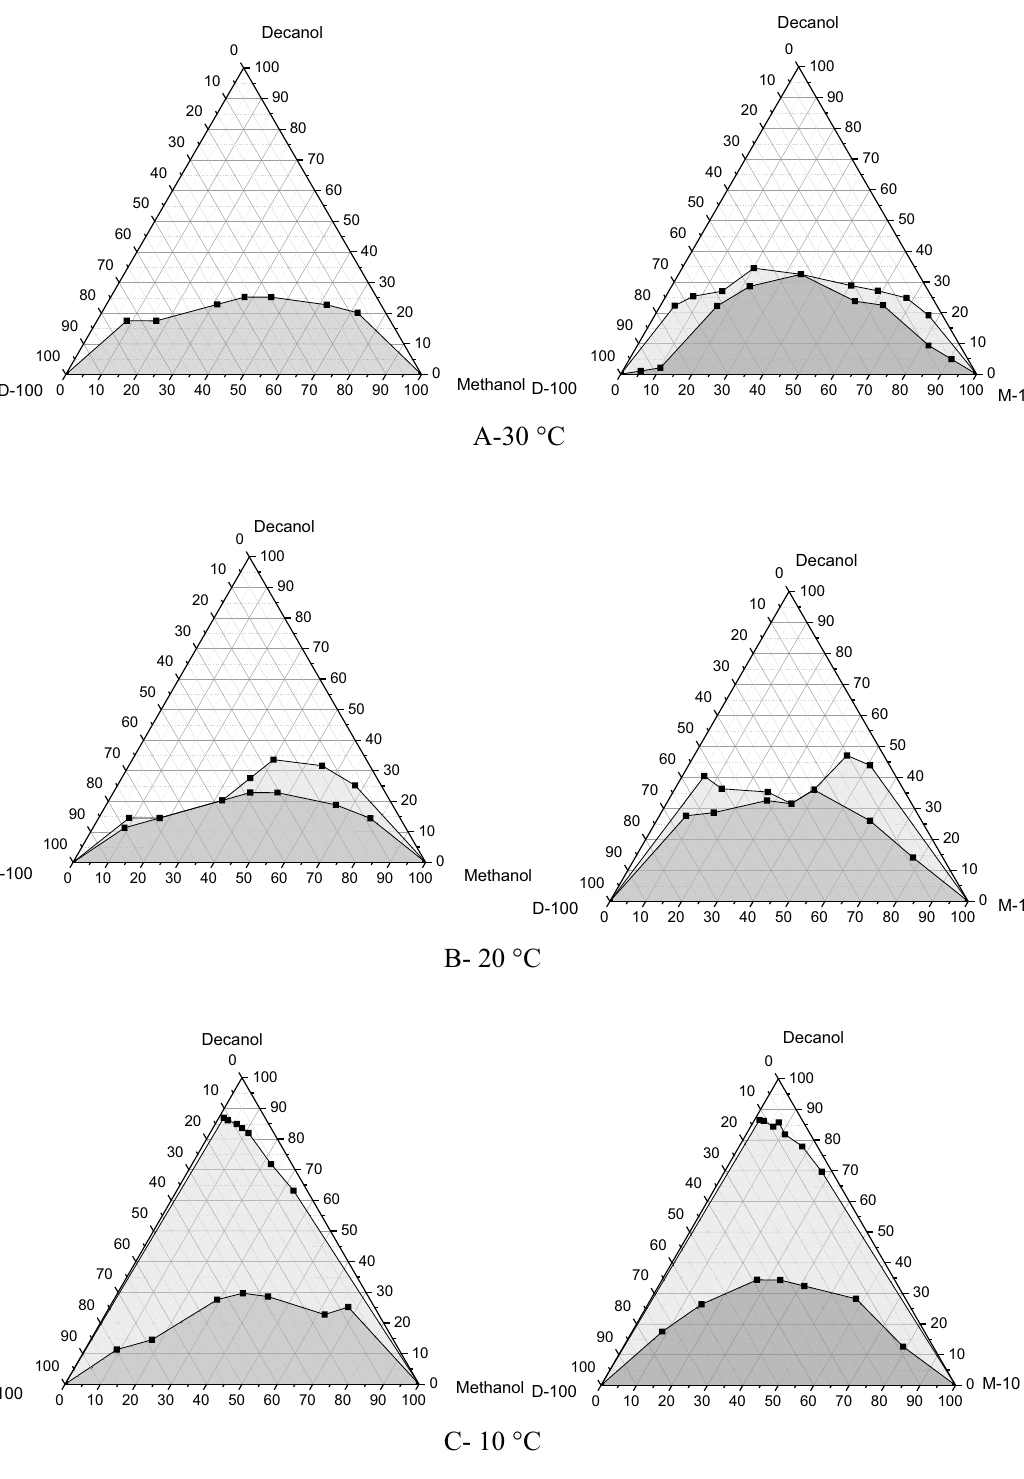
Figure 1. Change in the miscibility of M100 and hydrous methanol with diesel, manipulating n-decanol as cosolvent, at several